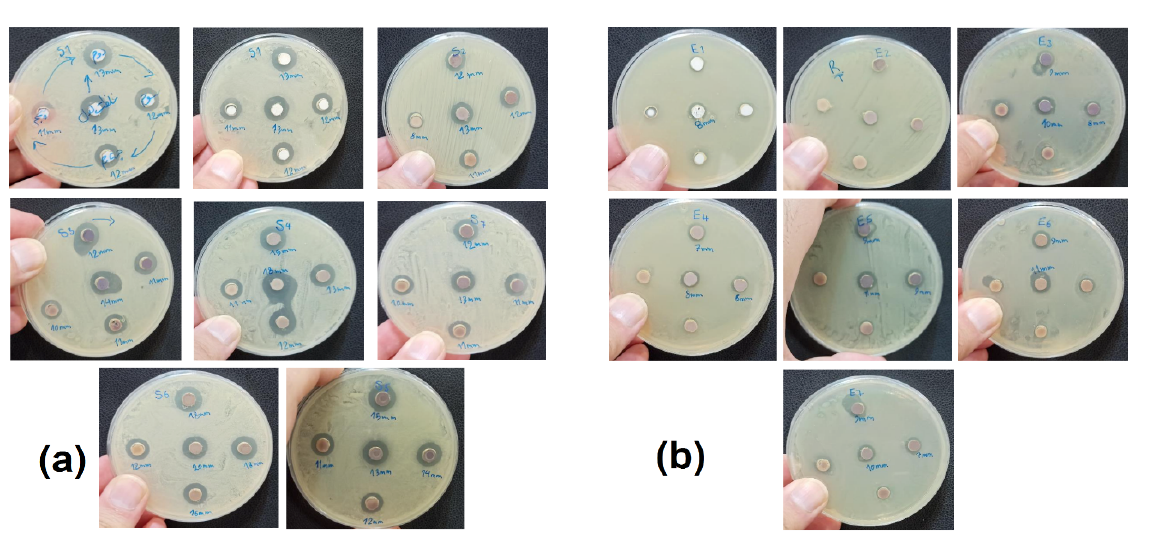
Figure 5. Antibacterial test results and zone of inhibition generated by zinc oxide (ZnO) and silver (Ag) X%/ZnO (X=1-6 wt%) nanoparticles (NPs) in the presence of (a) S. aureus and (b) E.